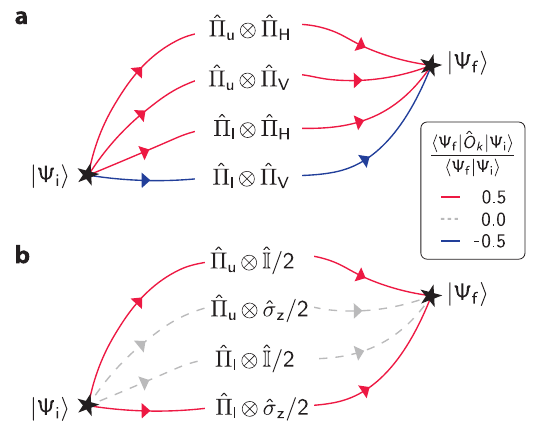
Fig. 4 Conceptual Feynman diagrams for the transition from Ψ i j i to Ψ f j i . The virtual paths de fi ned by ^ O k can be arbitrarily set to satisfy P P ^ I ^ O ^ O ^ O ^ Π ^ Π Ψ ; so that h Ψ f j Ψ i i ¼ h Ψ f j k ¼ k j i i . a k ¼ f u (cid:2) H k k ^ I = ^ I = ^ O ^ Π ^ Π ^ Π ^ Π ^ Π ; ^ Π ; ^ Π 2 ; ^ Π u (cid:2) ^ σ z = 2 ; ^ Π l (cid:2) 2 ; u (cid:2) V l (cid:2) H l (cid:2) V g , b k ¼ f u (cid:2) ^ Π ^ Π ^ σ = 2 g , where ^ Π l (cid:2) z u and l represent the spatial modes of the state and ^ Π H and ^ Π V represent the polarization modes of the state. The transition amplitudes along the virtual paths in a and b are ^ I ^ Π ^ Π ^ Π ^ Π ^ σ related with each other due to ¼ H þ V and z ¼ H (cid:3) V . The line color shows the normalized transition amplitude of each virtual paths by the total transition amplitude 〈 Ψ f ∣ Ψ i 〉 for the initial and fi nal states in Eqs. (1) and